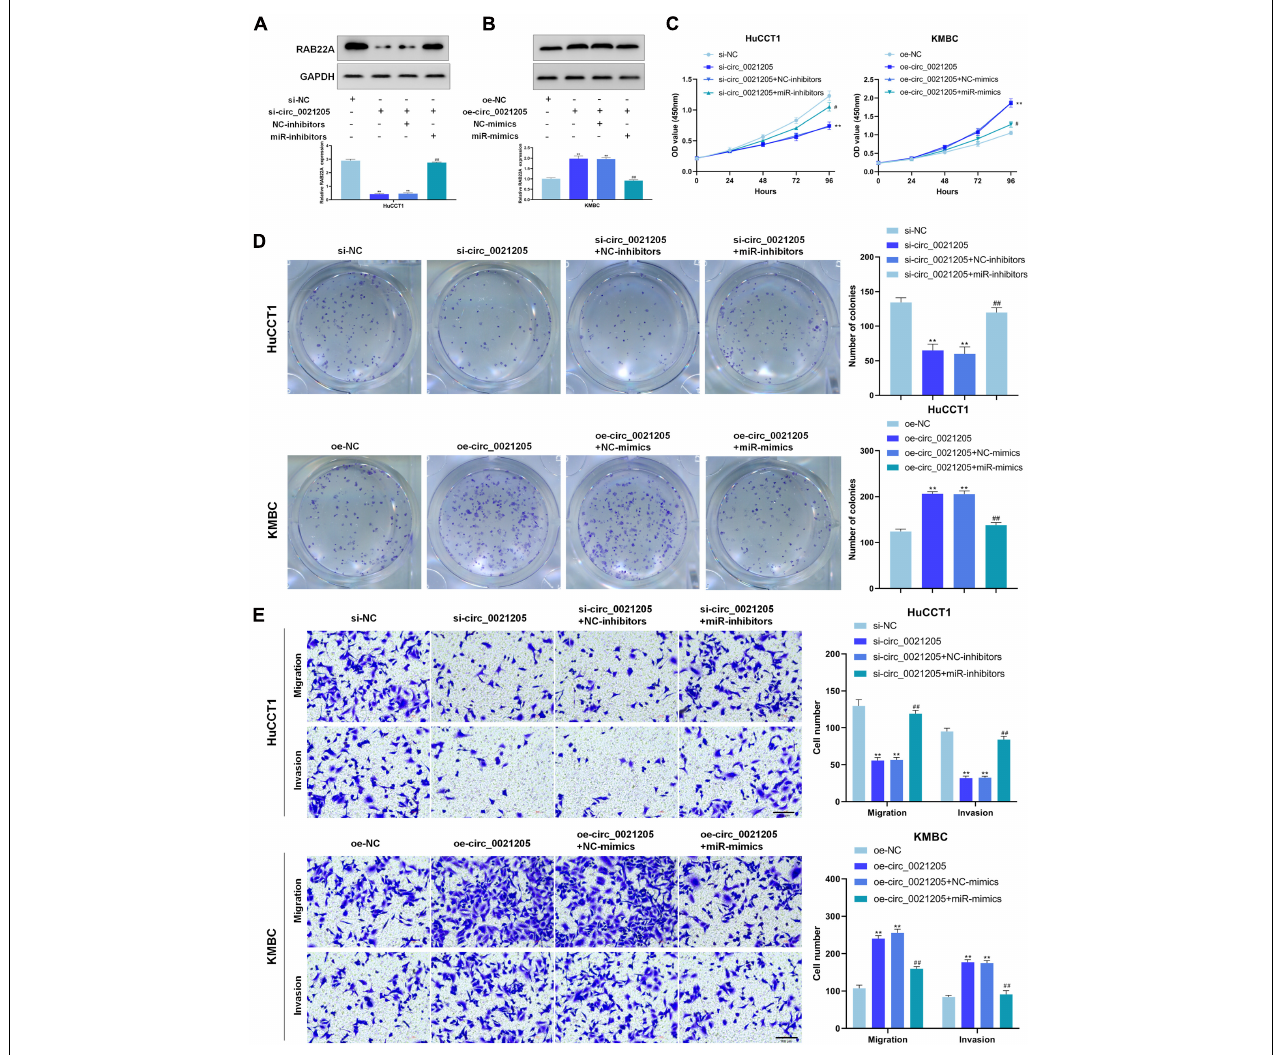
FIGURE 5 | Circ_0021205 suppresses CCA cell proliferation, migration and invasion through miR-204-5p/RAB22A axis. (A,B) Western blot results showed that circ_0021205 regulated RAB22A expression through sponging miR-204-5p. (C,D) The proliferation ability of treated HuCCT1 and KMBC cells were detected by CCK-8 assay and colony formation assay. (E) Transwell assay was performed to detect the migration and invasion of treated HuCCT1 and KMBC cells. All experiments were repeated at least three time. ** P < 0.01. # and ## mean the significant differences between oe-circ_0021205 + miR-mimics and oe-circ_0021205 + NC-mimics or si-circ_0021205 + miR-inhibitors and si-circ_0021205 +